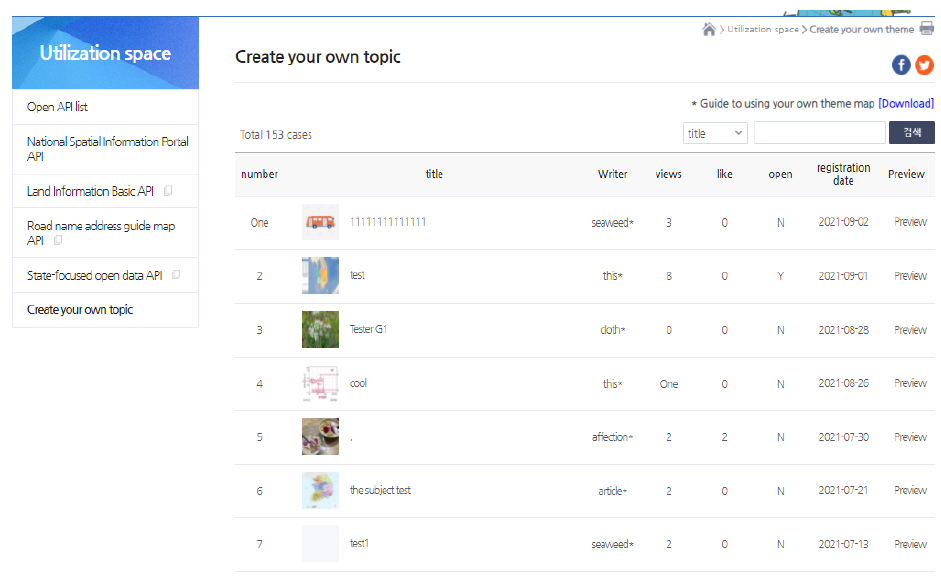
Table 3. Evaluation of stakeholder participation in NSDIP.